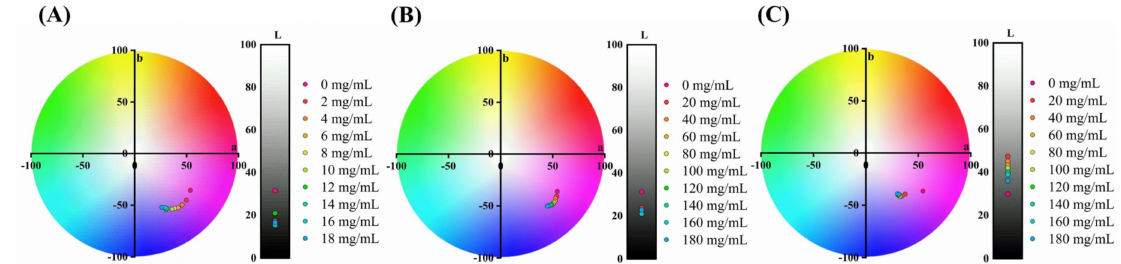
Figure 2. The effect of concentration of compounds on the colour appearance of antho- cyanins. ( A ) Anthocyanins − Pro − Xylane (ACNs − PX); ( B ) Anthocyanins − Ectoine (ACNs − ECT); ( C ) Anthocyanins − Dipotassium glycyrrhizinate (ACNs − DG).